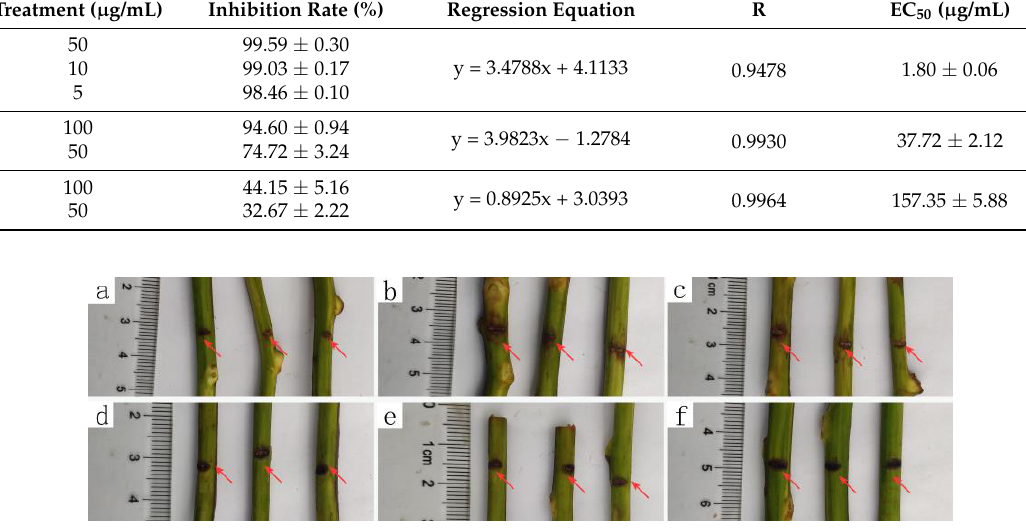
Table 1. In vitro antibacterial effects of three agents on Pseudomonas syringae pv. actinidiae (Psa).